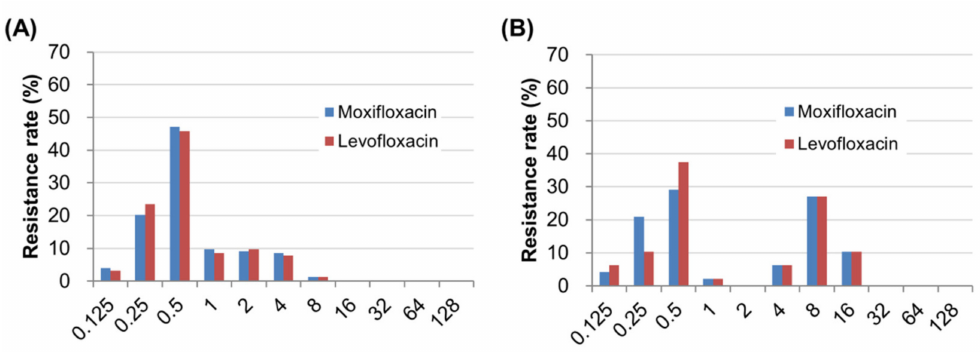
Figure 1. Distributions of MIC values for fluoroquinolones. MIC values for fluoroquinolones of ( A ) 153 strains (2005 / 2006) and ( B ) 48 strains (2017 / 2018) are visualized. MICs were determined by the agar dilution method. The MICs values for resistant strains ranged from 2–8 µ g / mL and from 4–16 µ g / mL at each period. MIC: minimum inhibitory